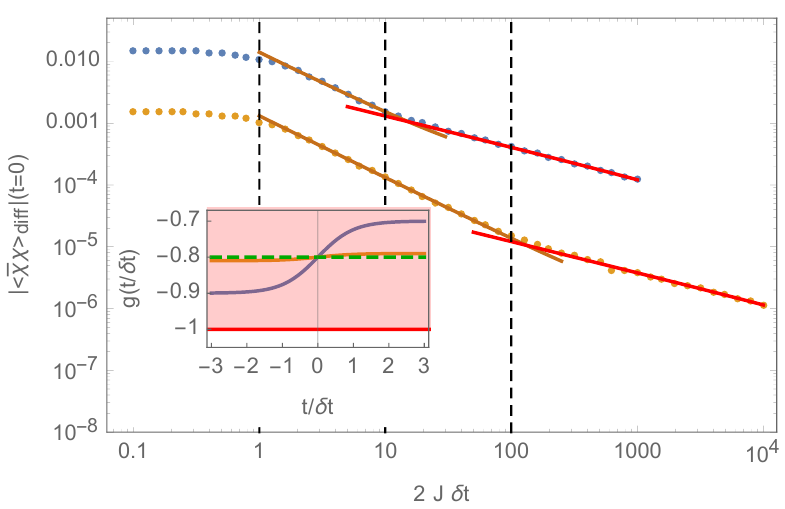
Figure 9 . Plot of h (cid:22) (cid:31)(cid:31) i di(cid:11) as a function of 2 J(cid:14)t for the interior-to-interior quench. The quench protocols are shown in the inset with g ( t=(cid:14)t ) = (cid:0) 0 : 8+ b tanh t=(cid:14)t , where b = 0 : 1 (blue), 0 : 01 (yellow). The green dashed line shows the value at which we are computing, g ( t = 0) = (cid:0) 0 : 8. The shaded red area is critical. The red (cid:12)ts are for functions P (2 J(cid:14)t ) (cid:0) 1 = 2 + Q with P = (cid:0) 0 : 00416 ; 1 : 22 (cid:2) 10 (cid:0) 4 ; Q = 1 : 01 (cid:2) 10 (cid:0) 5 ; 7 : 60 (cid:2) 10 (cid:0) 8 , respectively. The brown curves show the best (cid:12)t for functions P (2 J(cid:14)t ) (cid:0) 1 + Q with P = 0 : 0139 ; (cid:0) 0 : 00131 ; Q = 1 : 42 (cid:2) 10 (cid:0) 4 ; 6 : 04 (cid:2) 10 (cid:0) 7